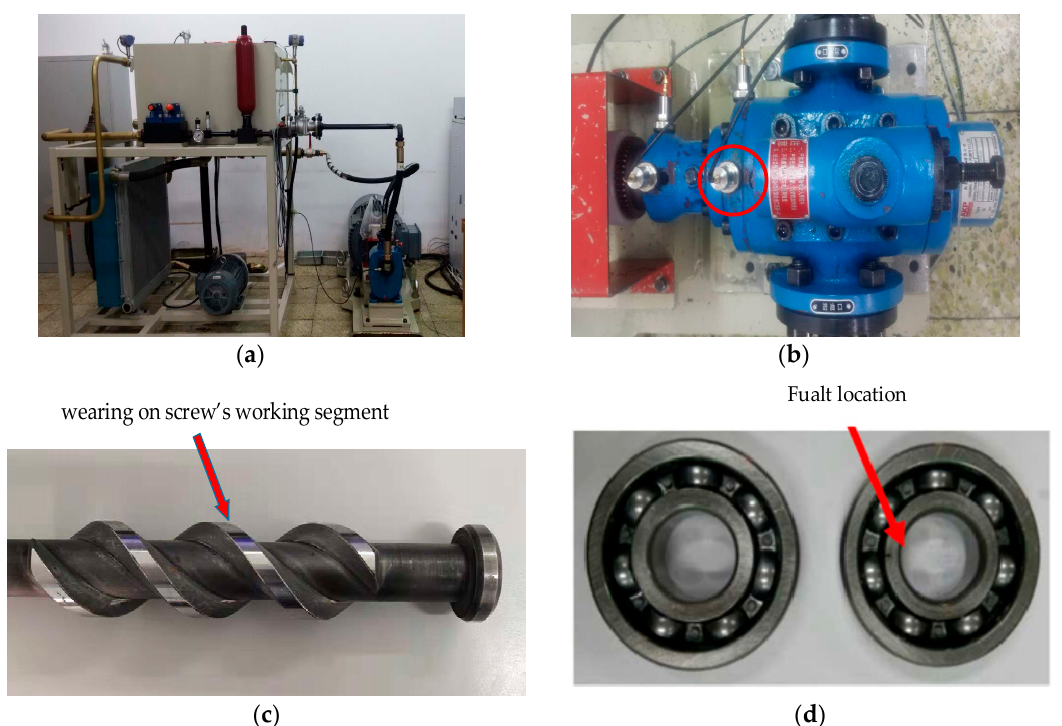
Table 3. Fault modes and sample